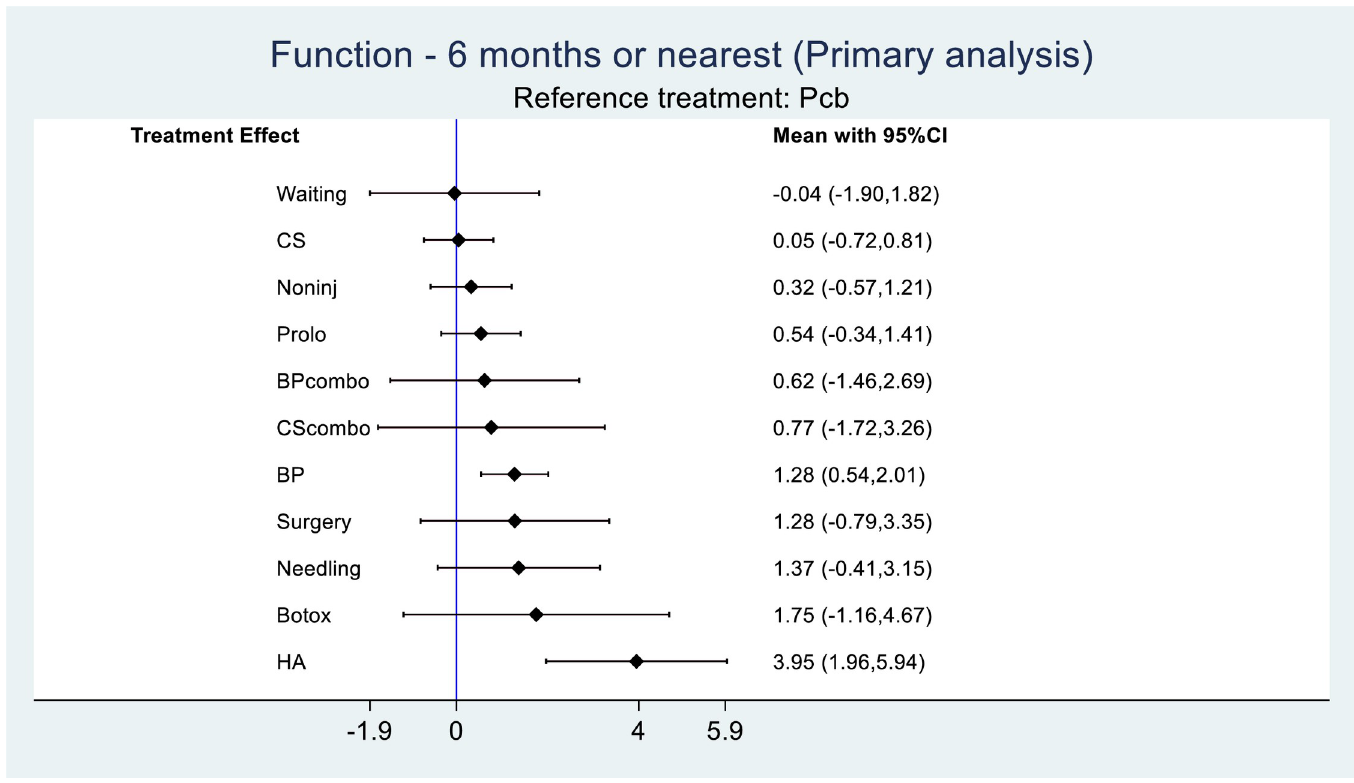
Fig 5. Functional outcome. Note: BP = blood product; BPcombo = blood product combination therapy; Botox = botulinum toxin; CS = corticosteroid; CScombo = corticosteroid combination therapy; HA = hyaluronic acid; Noninj = non-injections; Pcb = placebo; Prolo = prolotherapy.